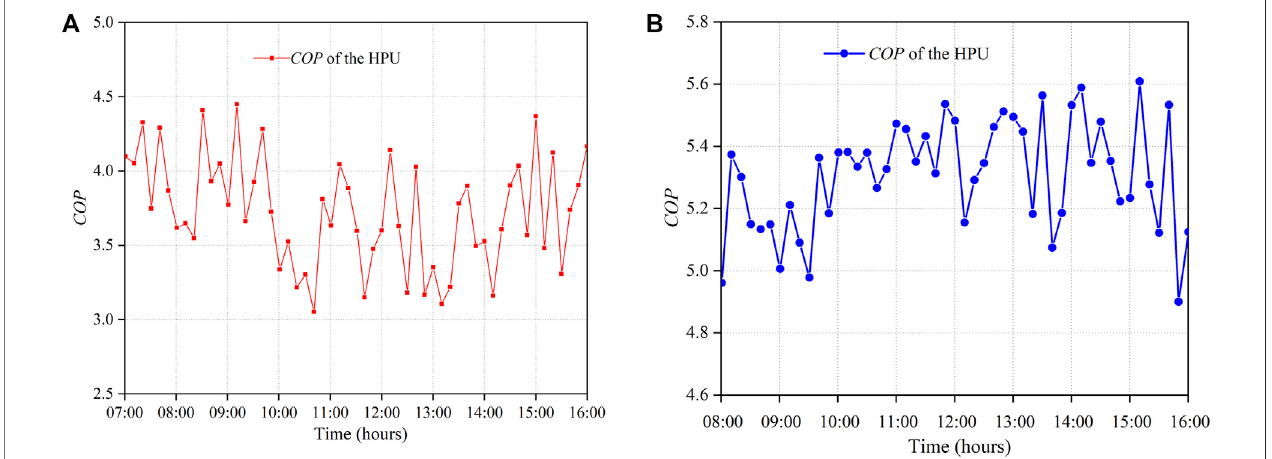
FIGURE 11 | COP of an HPU as a function of time for a typical day during (A) heating period (January 26, 2018) and (B) cooling period (July 4, 2017).